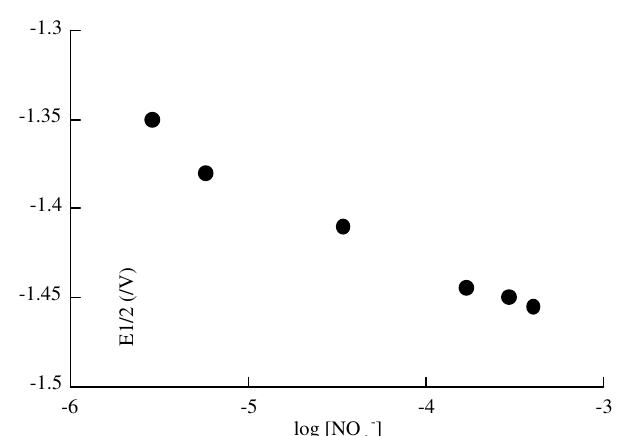
Figure 4 : Effect of the nitrite concentration on the reduction potential value of the Co (II) / Co (I)